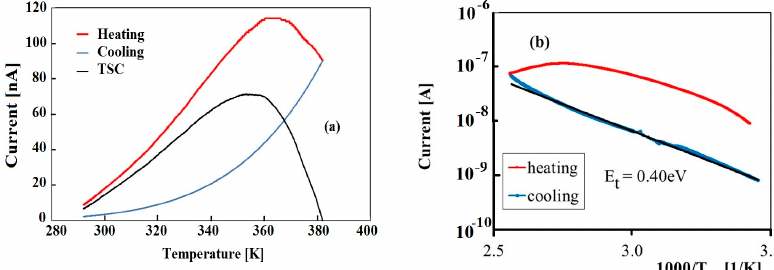
Figure 2. ( a ) Thermally stimulated current measured in the range 300–400 K after priming at T = 291.6 K, V b = 5 V, with a 400 nm LED source. ( b ) Same curve vs. 1000/T, with best fit of the cooling stage evidencing a decay of the current characterized by an activation energy E t = 0.40 eV.